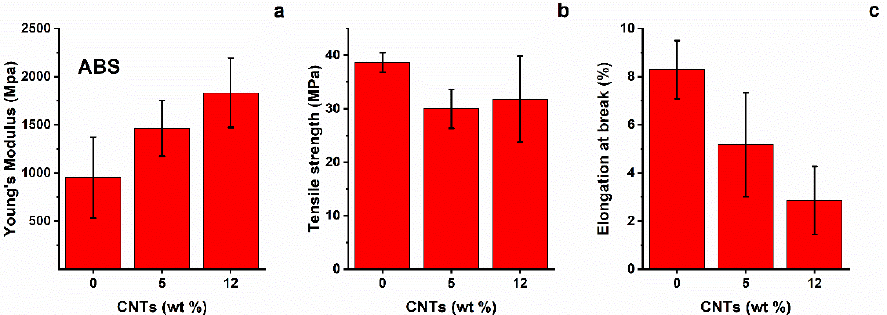
Figure 5. ( a ) Young ’ s modulus, ( b ) tensile strength, and ( c ) strain at break of ABS nano-compo- sites.